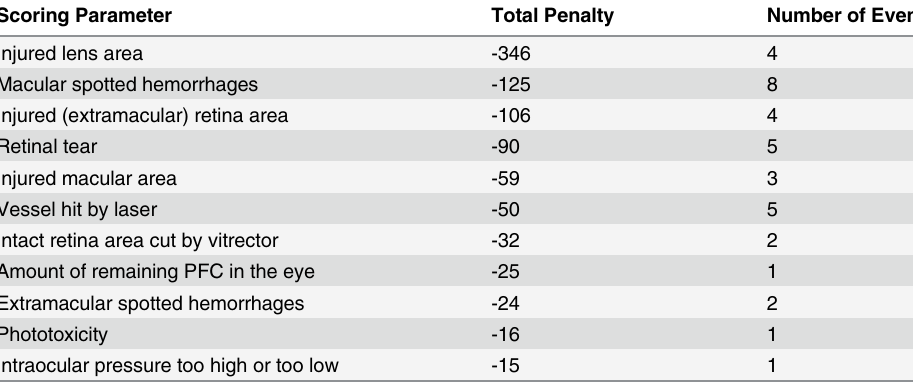
Table 1. The most prominent “ faults ” during simulator training. Scoring Parameter